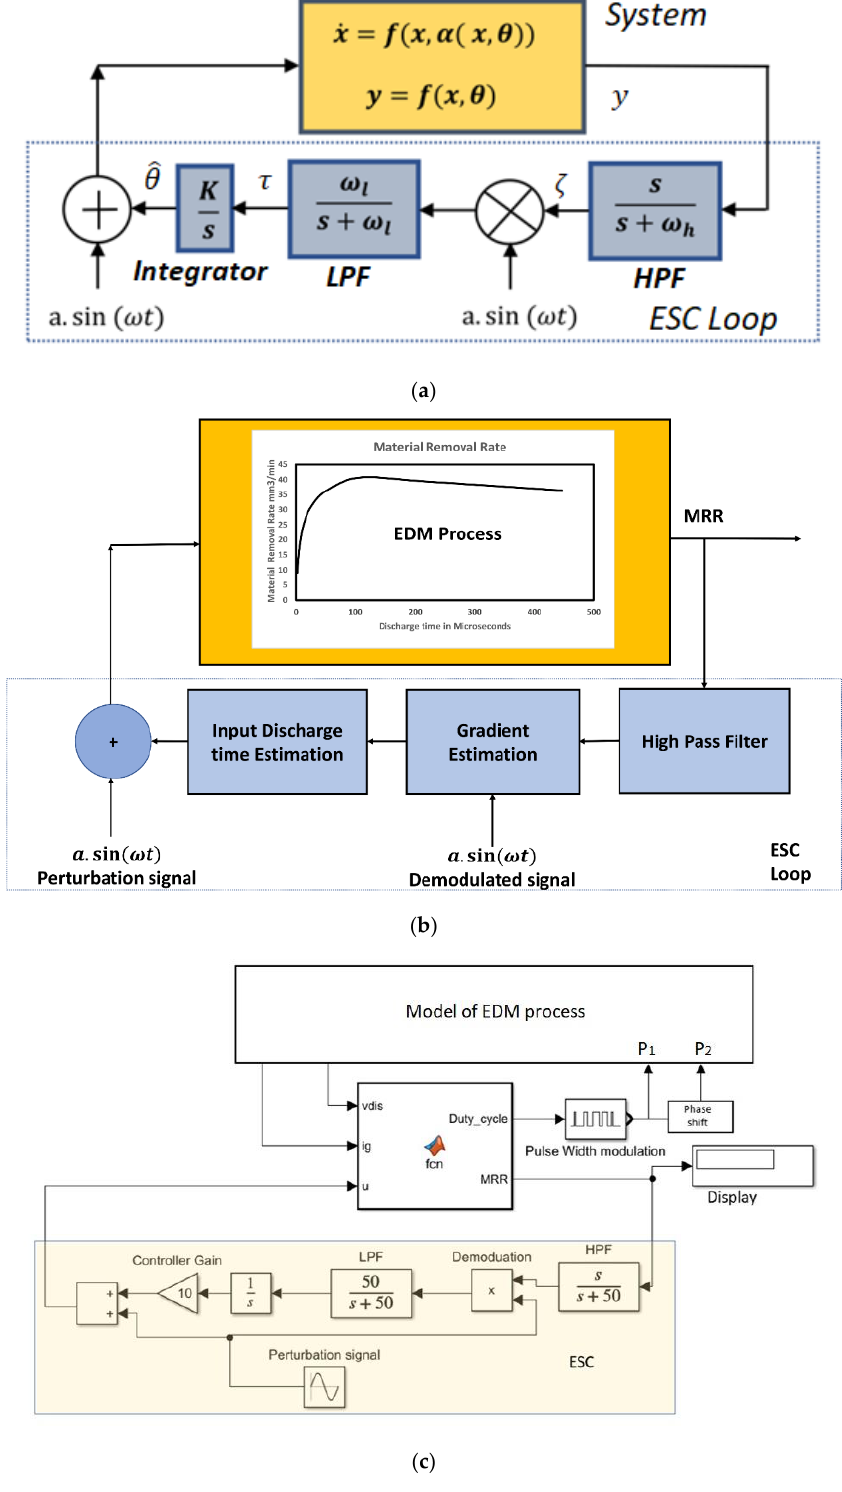
Figure 6. Methodology of extremum-seeking control for the EDM process. ( a ) Extremum-seeking control structure in a closed loop. ( b ) A detailed schematic of the proposed extremum-seeking control for the EDM process. ( c ) A detailed schematic of the proposed extremum-seeking control for the EDM